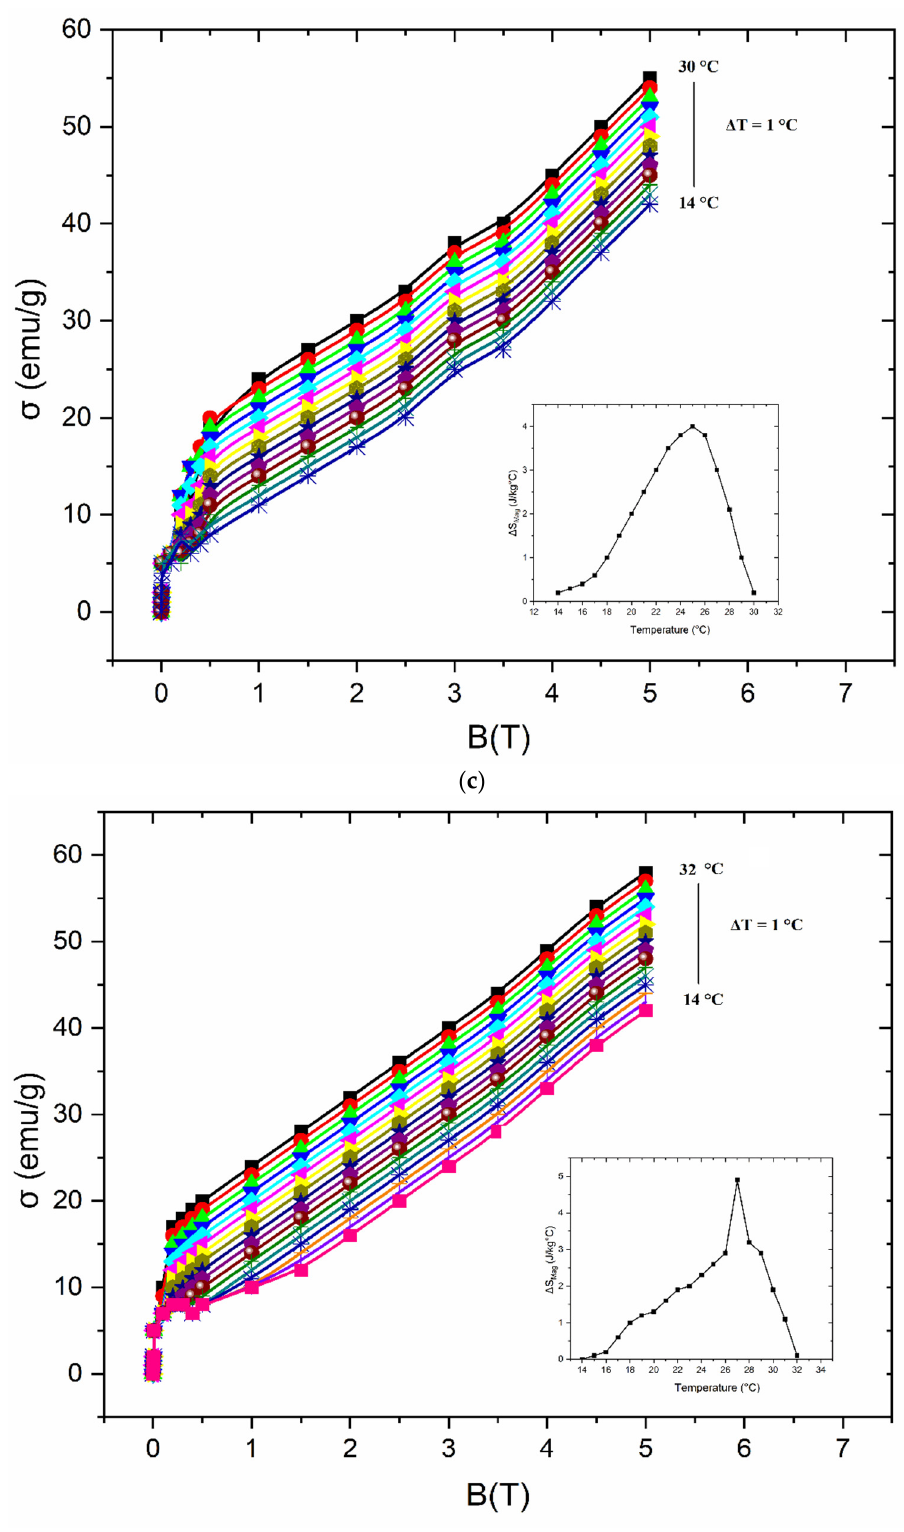
Figure 1. Isothermal magnetization plots for alloy sets where for Ni 50 − x Fe x Mn 30 Sn 20 − y In y , 1 ≤ x ≤ 4; 2 ≤ y ≤ 8 alloy and ( a ) x = 1, y = 2; ( b ) x = 2, y = 4; ( c ) x = 3, y = 6; and ( d ) x = 4, y = 8. For the change in flux ∆ B = 5 T in (2), we obtain RC = 130 J/kg at TA = 33 ◦ C point in the alloy with x = 4. Such a large RC value and the change in entropy ( ∆ S m ) arise